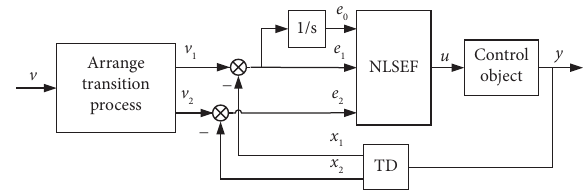
Figure 8: Principle of the improved PID controller.